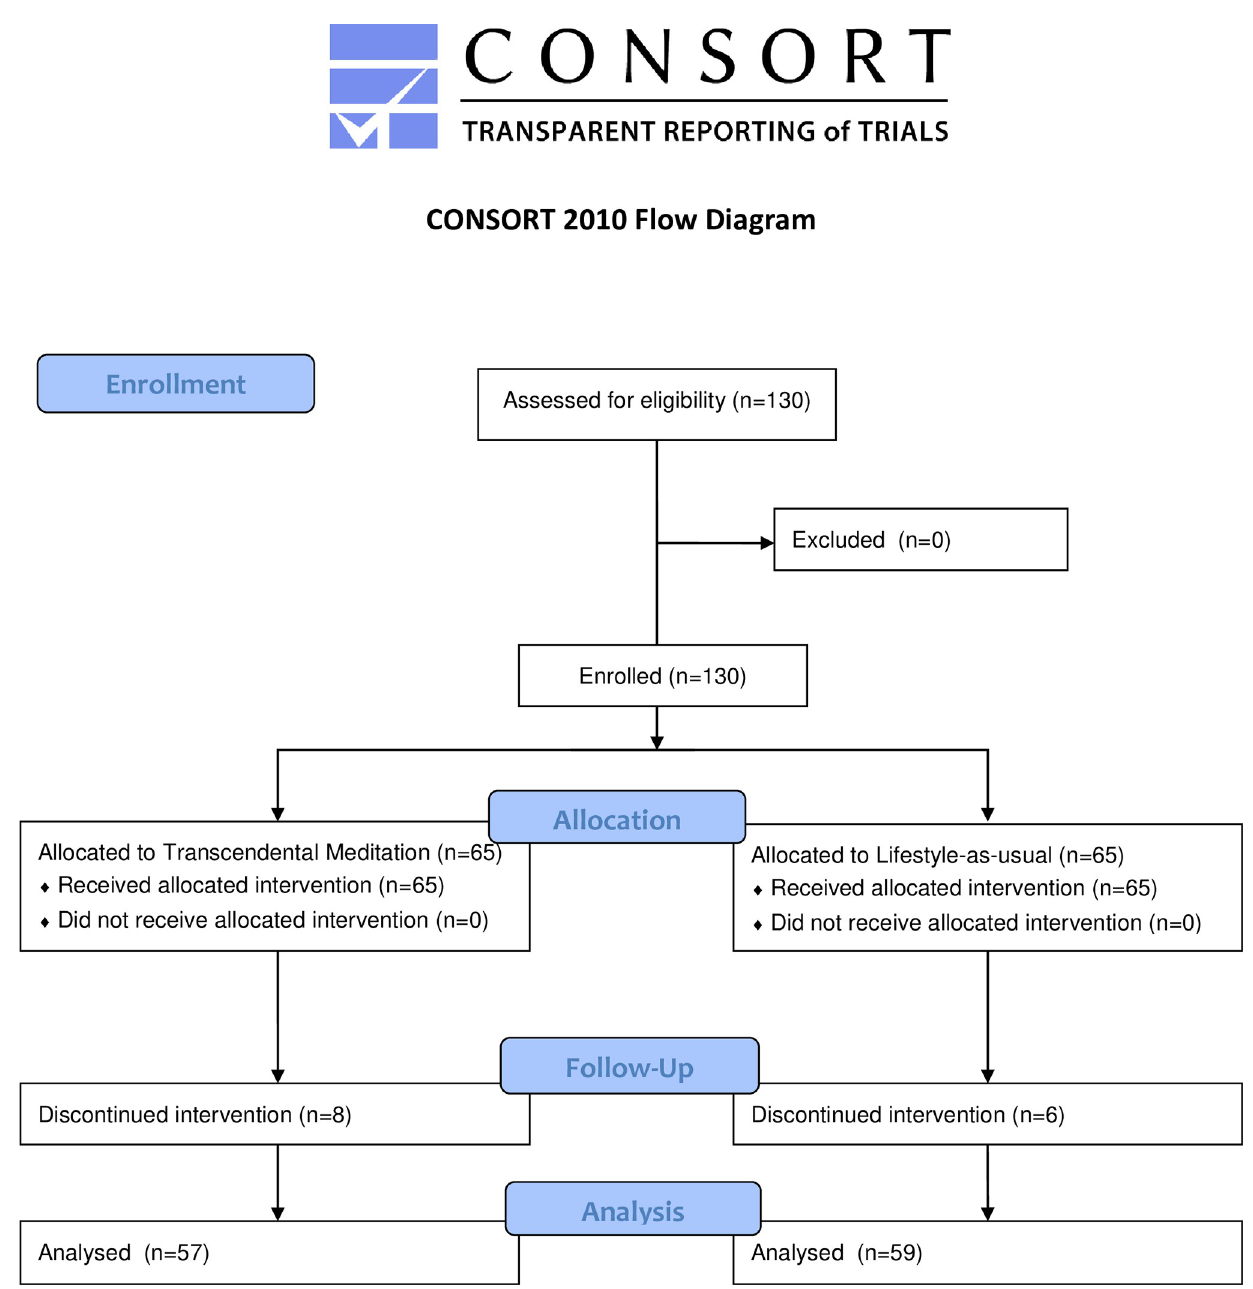
Fig 1. Consort trial flow diagram for analyzed